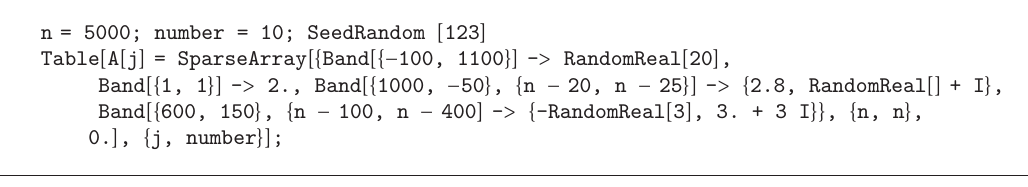
Table [ A [ j ] = SparseArray [{ Band [{− 100, 1100 }] - > RandomReal [ 20 ]